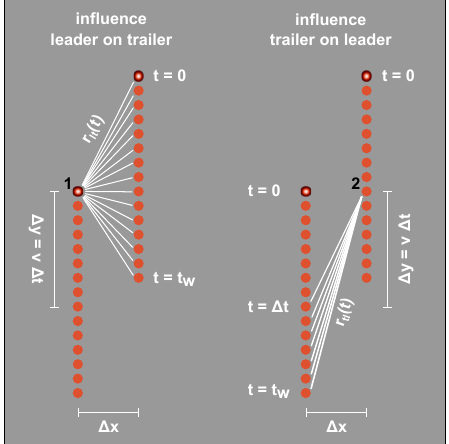
Figure 5. Radical diffusion scheme. Left : the leading line affects the trailing line. Radicals diffuse from various positions on the leading line ( red circles) to position 1 (marked by the black 1). The white lines denote the diffusion distance which changes over time. The lines indicate diffusion prior to the trailing ( t ) = ∆ x 2 + ( ∆ y − vt ) 2 ( v is the writing speed). spot reaching position 1. It follows from the figure: r 2 lt t w is the total writing time. Right : the same as the left but indicating how the trailing line affects the ( t ) = ∆ x 2 + ( vt ) 2 leading line. Here, we find: r 2 tl